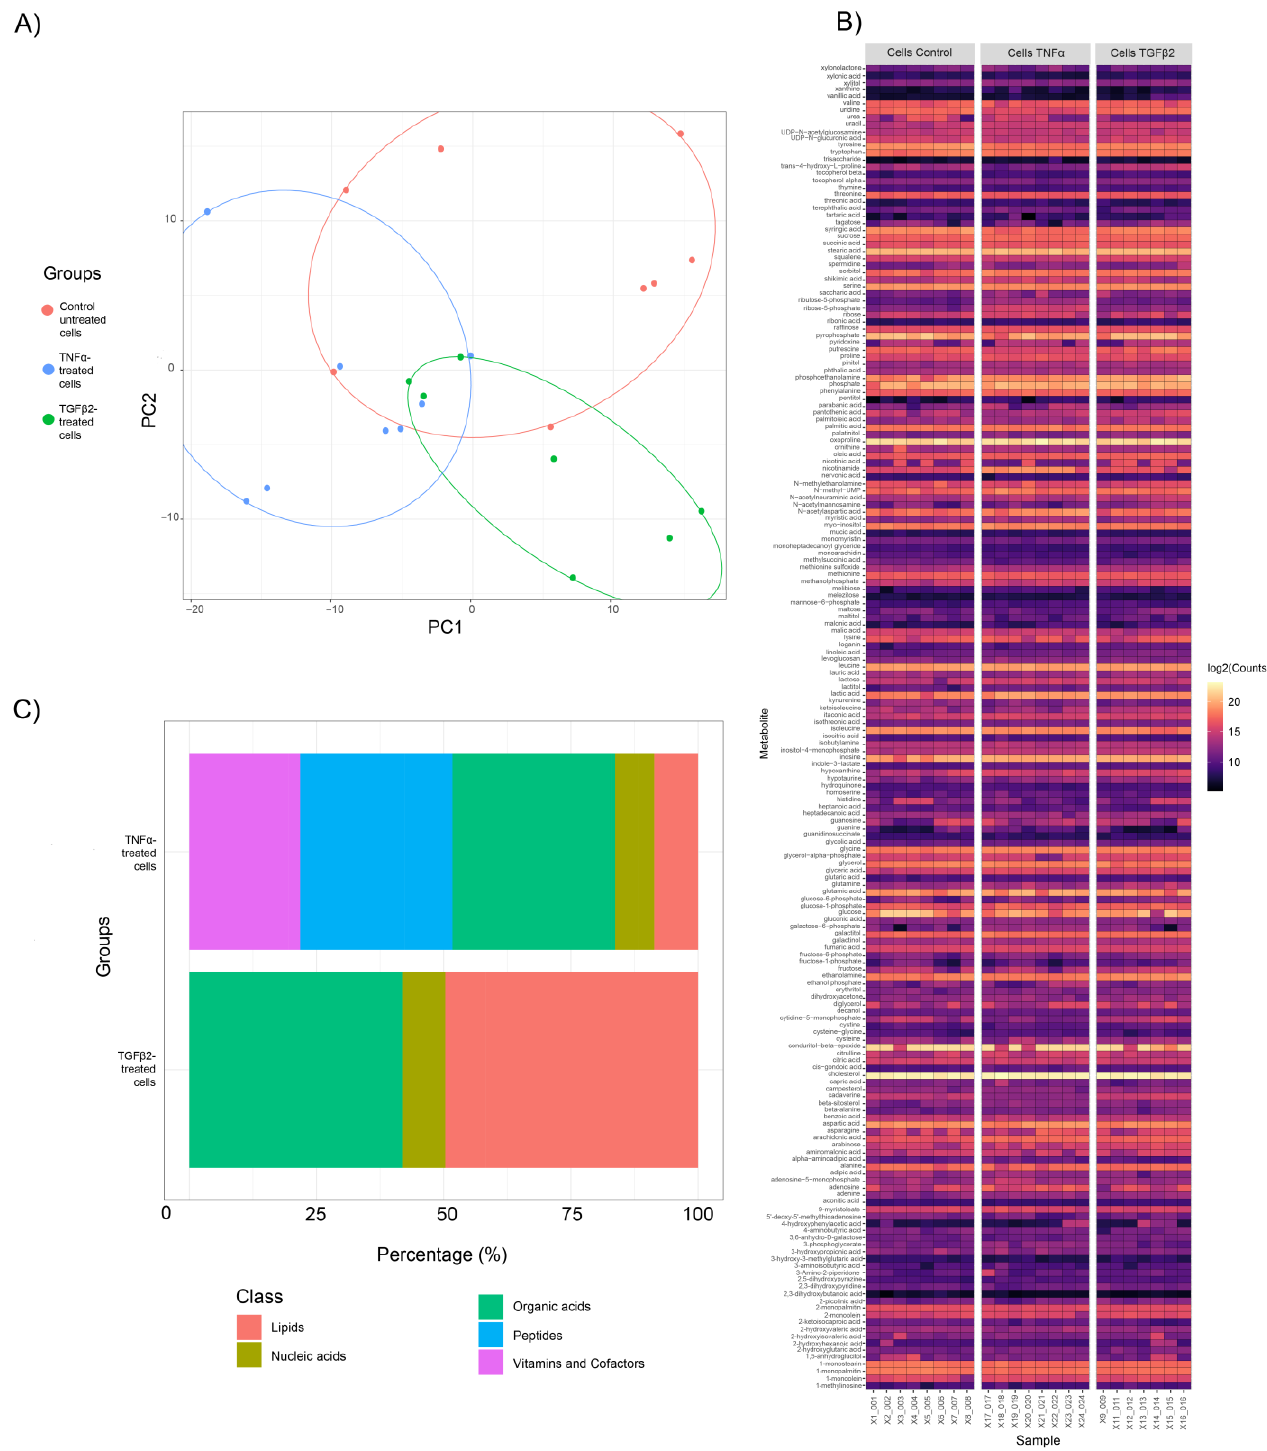
Figure 1. Metabolite profile clustering of TNF α - and TGF β 2-treated H-RPE cells compared to untreated control cells. ( A ) Principal Component Analysis (PCA) score plots show distinct clusters for samples in the control, TNF α and TGF β 2 cellular metabolite groups. ( B ) A heatmap of the differential fold changes for all annotated metabolites in each sample analyzed for the three groups. ( C ) Categorization of differentially expressed metabolites between TNF α - and TGF β 2-treated H-RPE cells compared to untreated control cells.